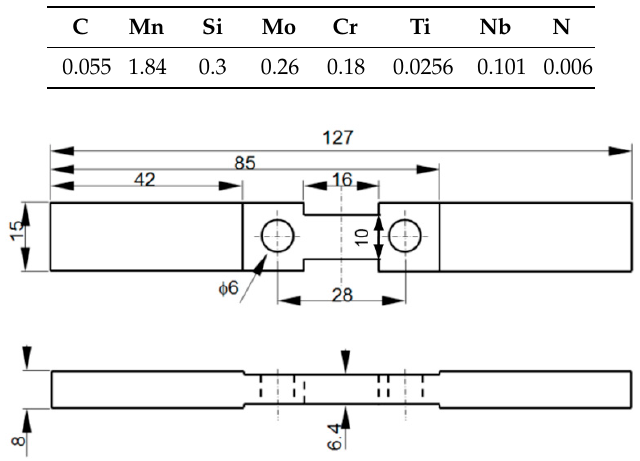
Figure 1. The flat compressing sample (dimensions in mm). The sample was used for tensile testing after applying the TMP. Table 1. Composition in wt. % of the studied material.